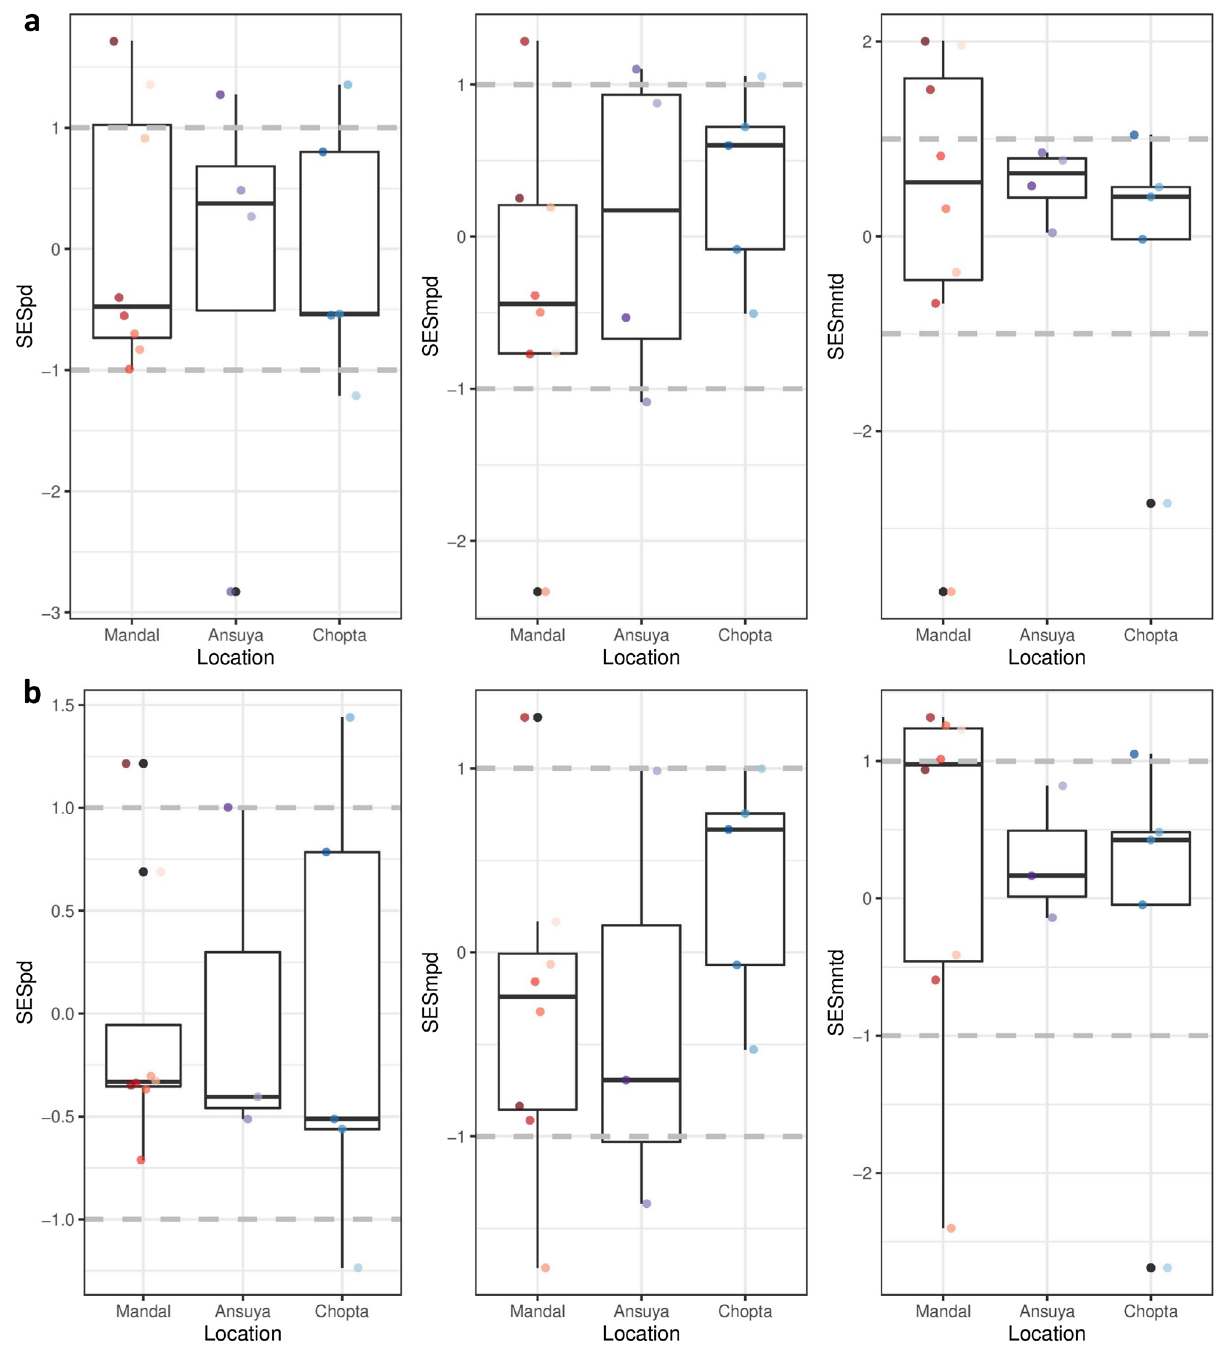
Figure 5. SES values of different elevational communities for corresponding PD indices obtained from constrained randomizations with 999 iterations; measured using acoustic detections as relative abundance for all species/sonotypes. ( a ) For all species, ( b ) for species excluding rhinolophids. |SES|= 1 and above are significantly different from the null model (for more details on SES see “Methods” Therefore, our data do not adequately resolve whether SR declines monotonically across the full elevational range or exhibits a decline from a mid-elevation peak at 1500 m. The decline in Simpson’s Diversity Index was non-linear (Fig. 3b) with elevation, such that it did not differ significantly between Chopta and Ansuya. This finding indicates that the community at Mandal had a few dominant species, whereas at higher elevations the dominance was less pronounced. The observed decrease in species richness with elevation is likely due to the synergistic effect of temperature on habitat and prey availability. Indeed, the elevational gradient is characterized by a strong temperature gradient with the average minimum summer temperature at Mandal (1500 m asl) being 15 °C, whereas that at Tungnath (3500 m asl) being ~ 1 °C, with frequent sleet and hailstorms. The dominant forest types and the density of